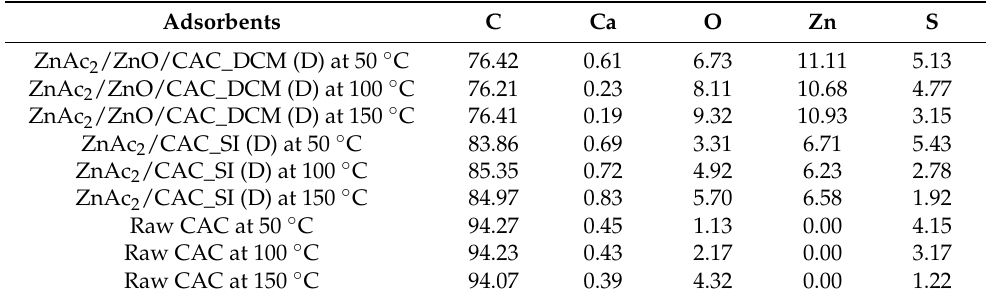
Table 6. EDX analysis results for the ZnAc 2 /ZnO/CAC_DCM, ZnAc 2 /CAC_SI, and raw CAC